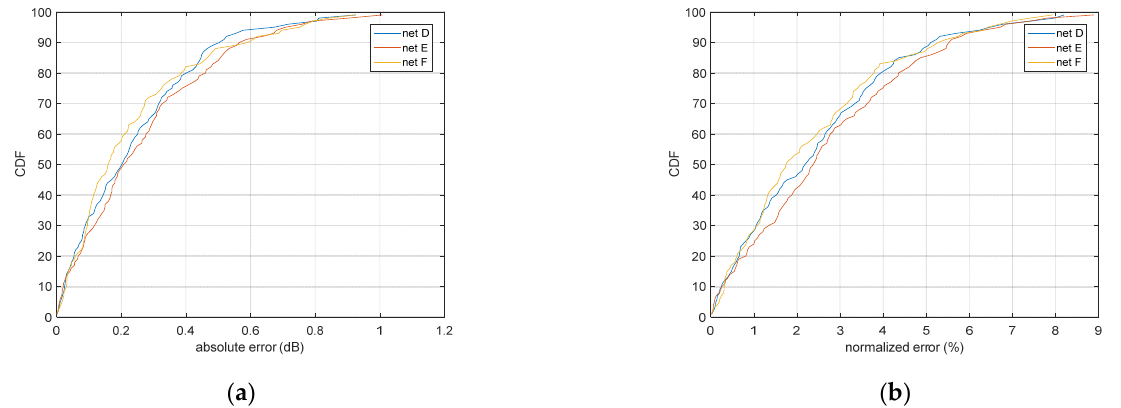
Figure 11. Error distribution of correlation distance extraction. ( a ) Absolute error; ( b ) Normalized error.